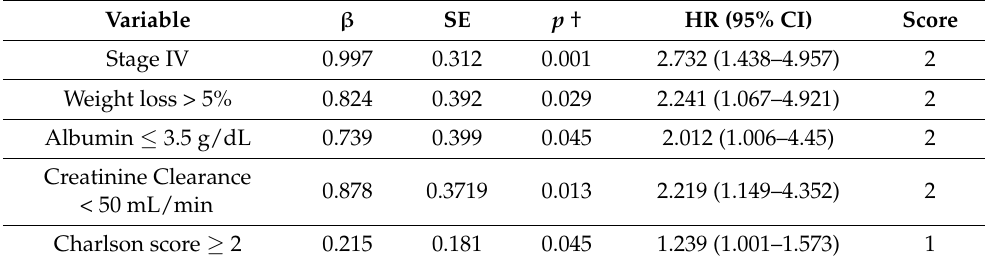
Table 4. Variables significantly associated with unplanned